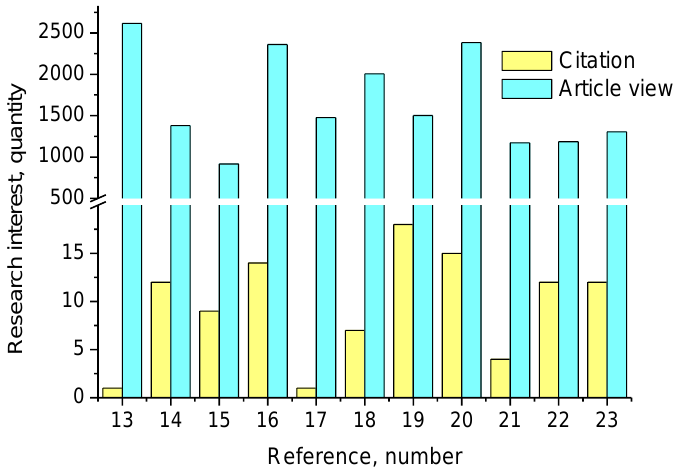
Figure 1. Research interest in the papers published in the SI “World of Biosensing” (references [13 – 23].